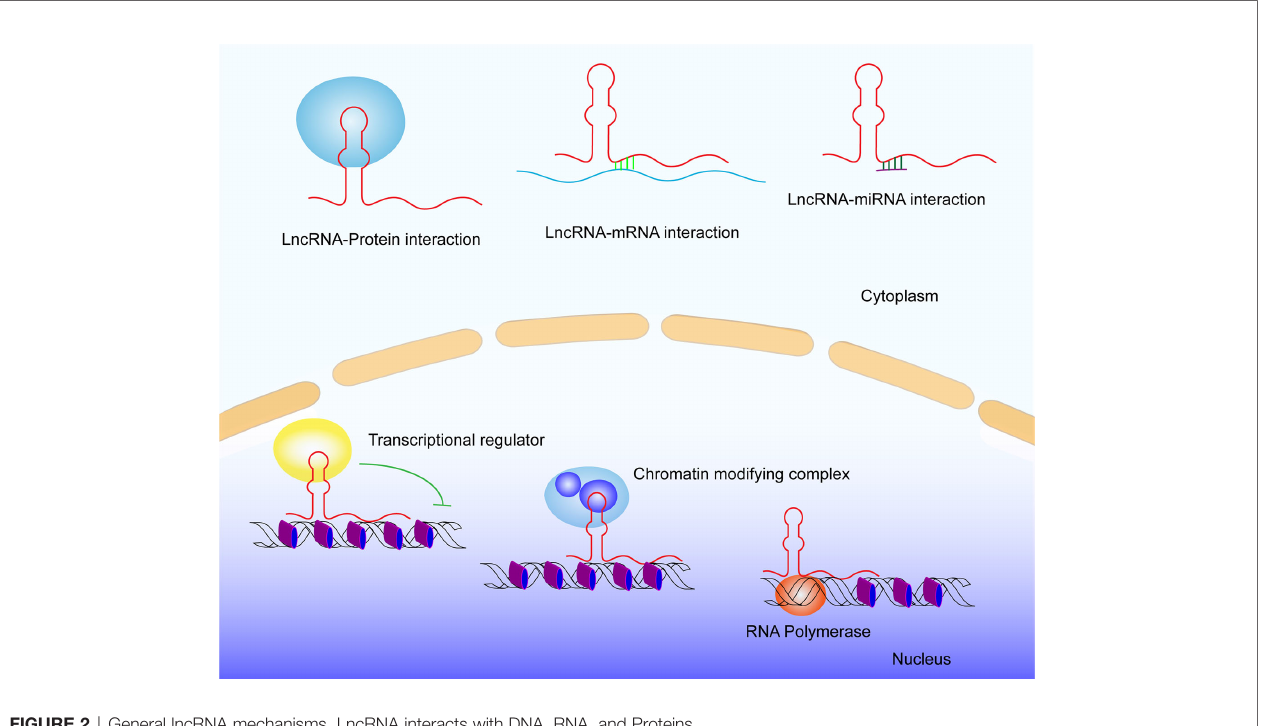
FIGURE 2 | General lncRNA mechanisms. LncRNA interacts with DNA, RNA, and